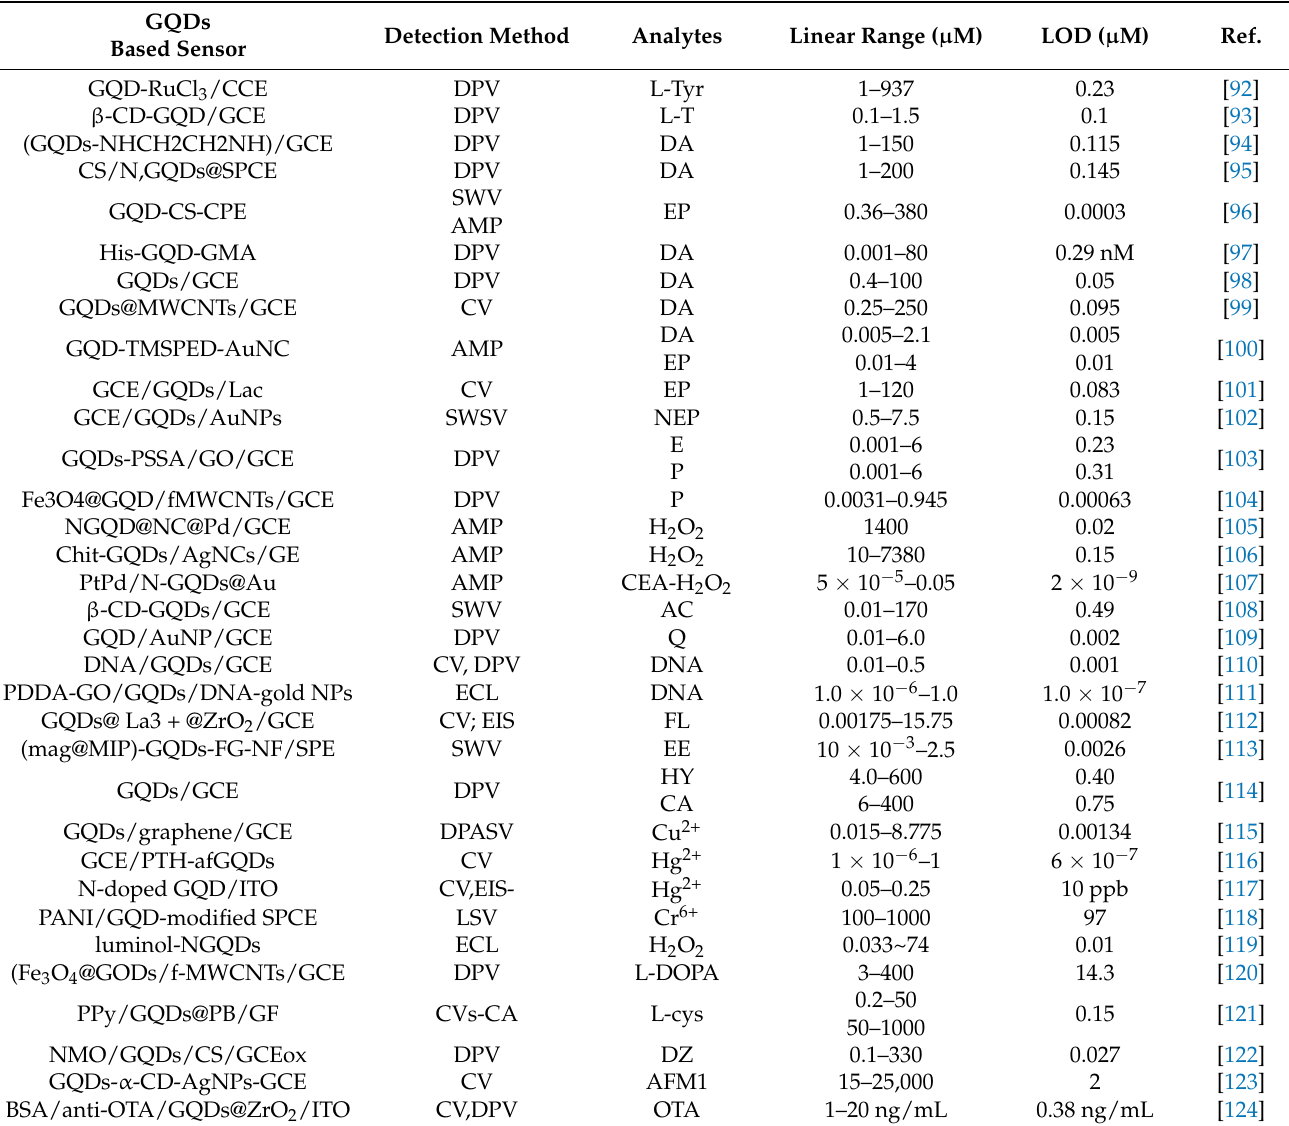
Table 2. Electrochemical performance of eco-friendly GQD based sensors for the detection of several analytes. GQDs Detection Based Sensor